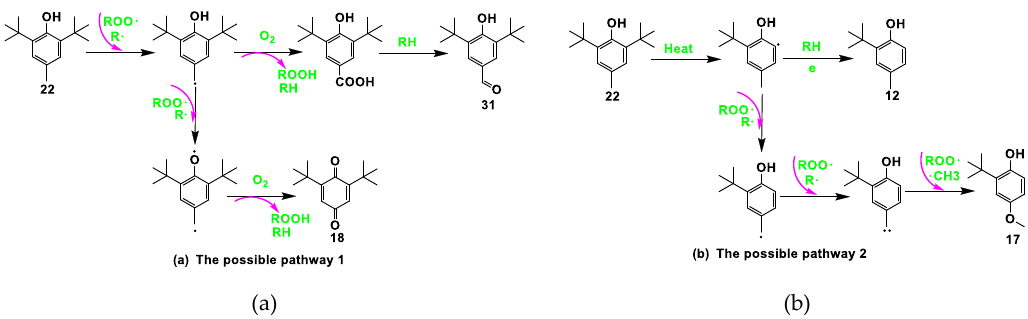
Figure 10. Possible reaction pathways of BHT. ( a )The possible pathway 1; ( b ) The possible pathway 2.